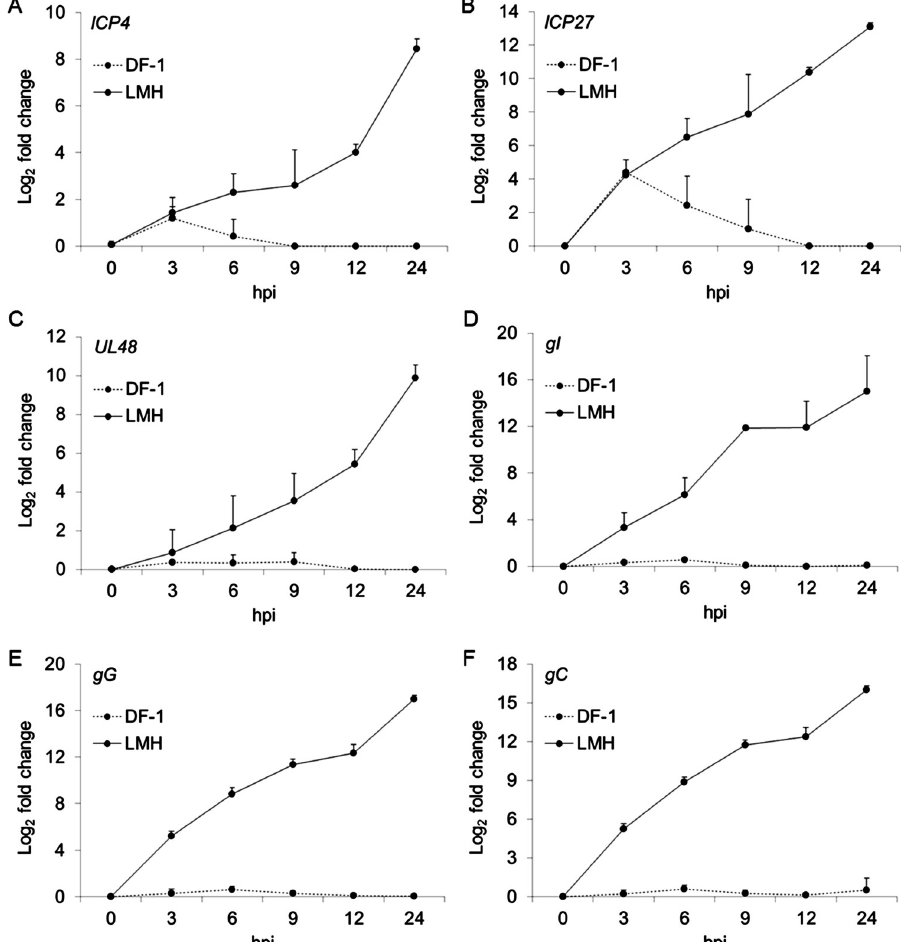
Fig 2. Detection of viral gene transcription in LMH cells and DF-1 cells. The transcription levels of six ILTV genes coving all stages of ILTV transcription, namely ICP4 (A), ICP27 (B), UL48 (C), gI (D), gG (E), and gC (F), in DF-1 and LMH cells were detected by absolute RT-qPCR at indicated time points post ILTV infection (MOI 1). Data are presented as the mean ± SD, n = 3.